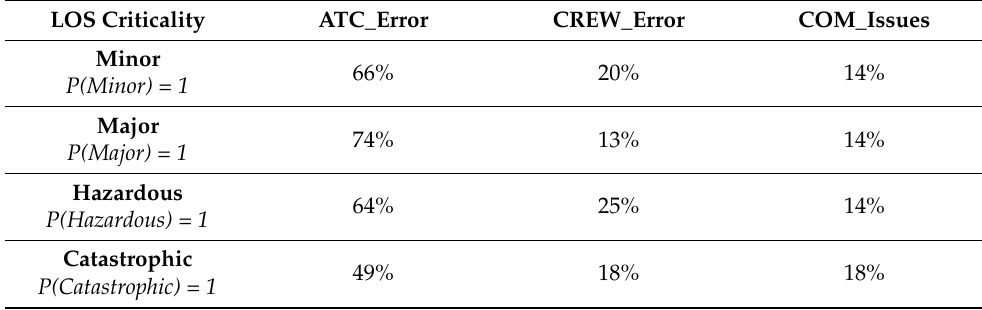
Table 8. Human factor and COM_issues contributing factors’ probability for LOS criticality.